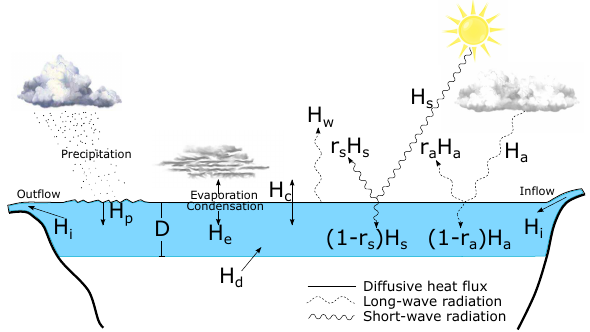
Fig. 1. Main heat exchange affecting the surface layer. For the description of the single terms refer to Appendix A.